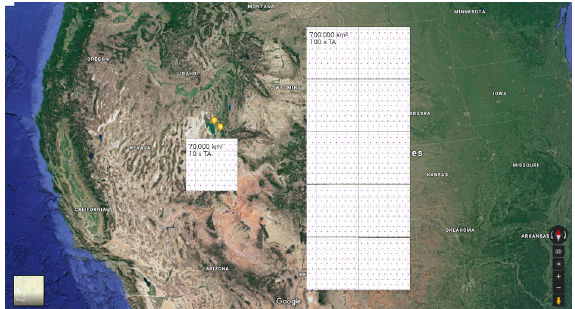
Figure 14. Idea of Huge array for ultra-high energy cosmic ray observation using CRAFFT detector. Map data c ⃝ 2018